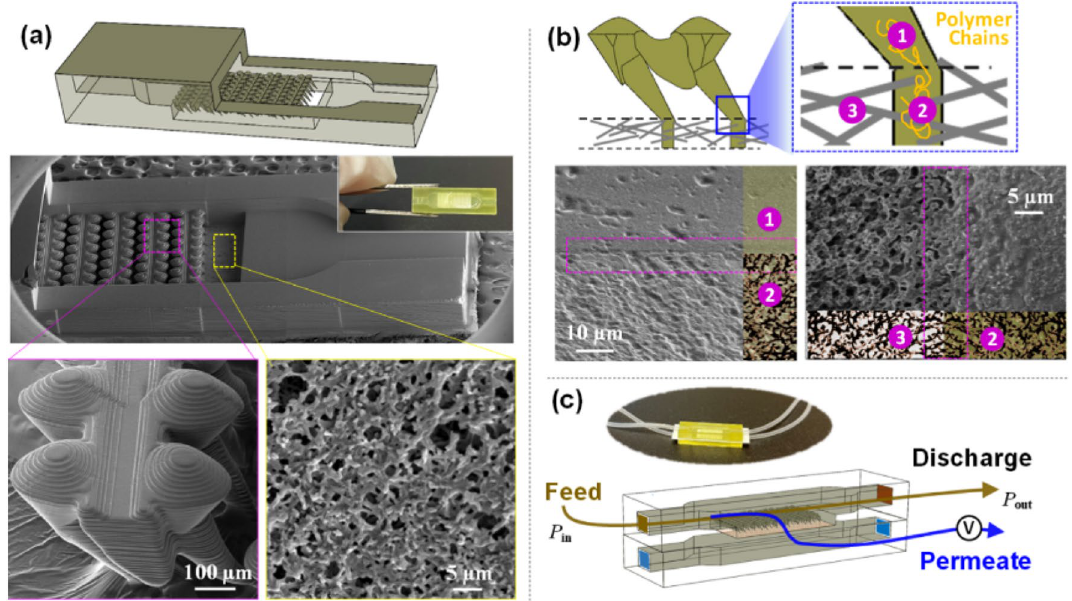
Figure 2. 3D-printed on-chip membrane filtration device with self-sealed interfaces. ( a ) Schematic and SEM images of 3D-printed fish-mimicked membrane filter. Membrane is embedded as printing substrate, where the fish gill structures and supportive frames are directly printed on it. (b) Self-sealed interfacial region between 3D-printed structure and membrane. When directly printing on membrane, the photo-polymerization and cross-linking process is illustrated in the schematic diagram, and the SEM images show the interfacial regions of printed structures and membrane (highlighted the dash box). The solidified printing resin within the membrane pores strongly bonds the printed structures above membrane, spontaneously achieving self-sealing properties. ( c ) Schematic of microfluidic platform for high-throughput filtration performance evaluation. Optical image of as-fabricated device is also provided. The microfluidic chip size is 7 mm in width and 19 mm in